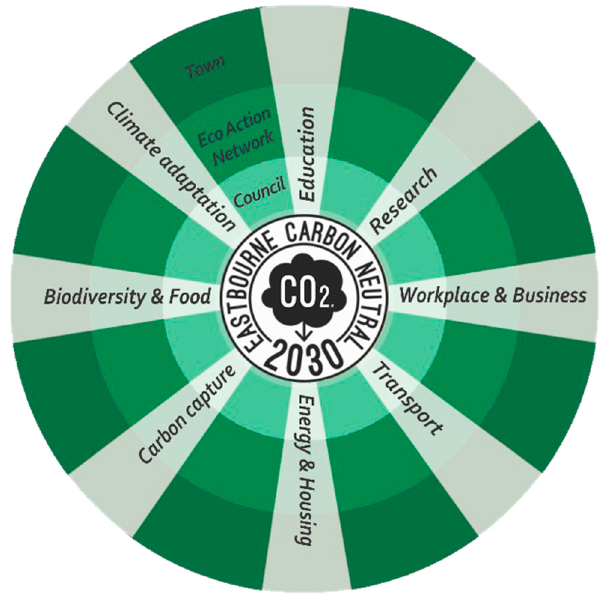
Figure 3. Visualisation of council-citizen collaboration @ P von Hellermann and Roxana Caporici.